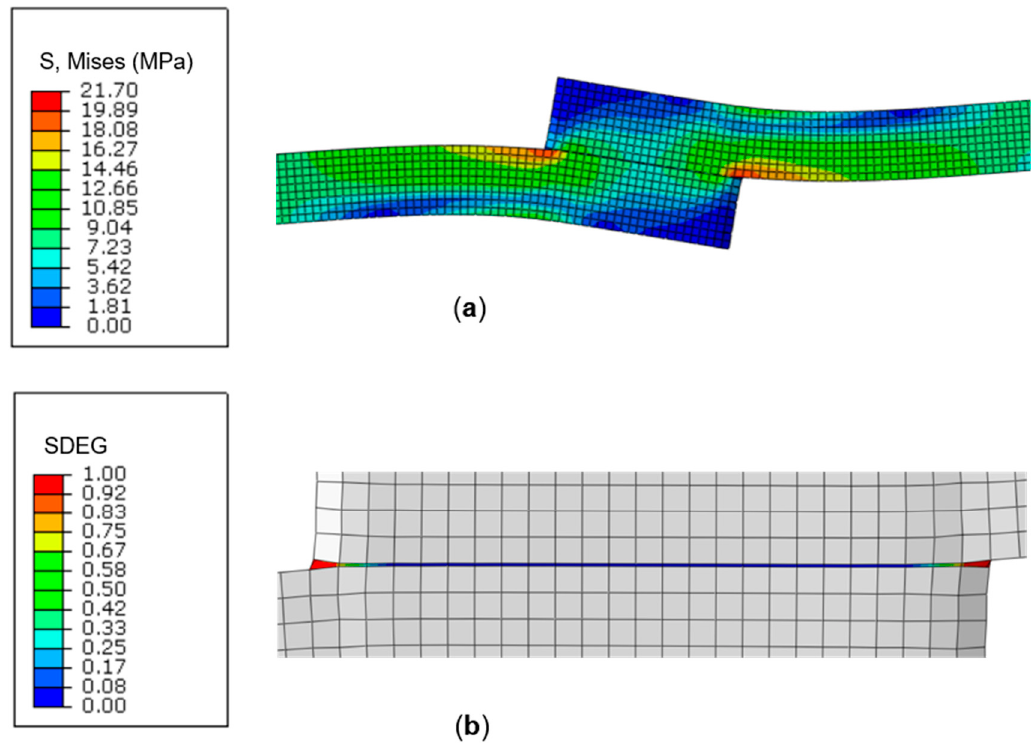
Figure 10. ( a ) Von Mises stress and ( b ) damage variable distribution (SDEG) contour plots for the lap-shear joint model.